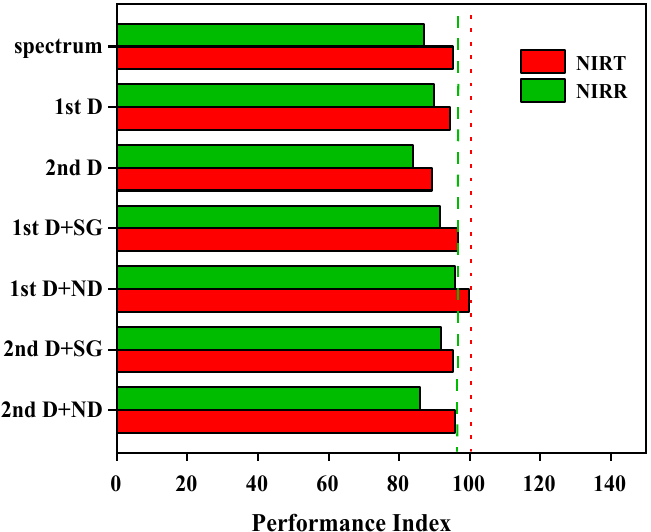
Figure 6. Performance indices of the different data-processing methods.